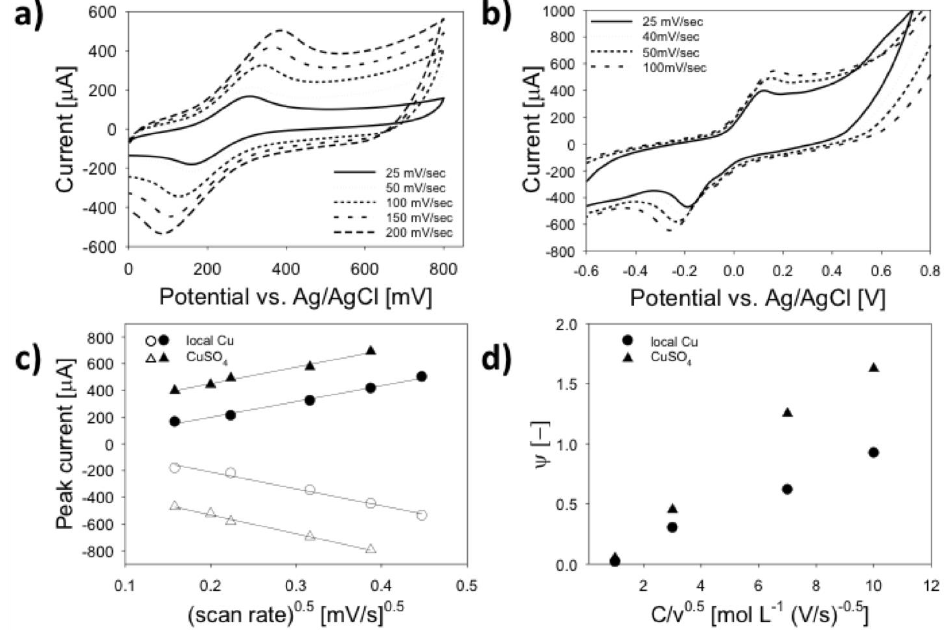
Figure 6. Representative CVs at various scan rates for LSG metallized with two types of copper source material. ( a ) CuSO 4 -plated LSG electrodes display reversible redox peaks; ( b ) LSG electrodes plated with locally sourced copper display quasi-reversible redox peaks below 100 mV/s, but no oxidation peaks are discernable above 100 mV/s (data not shown); ( c ) cottrell plots used to calculate ESA and HET constant were linear ( R 2 > 0.98) between 25 and 200 mV/s for CuSO 4 -plated LSG electrodes; ( d ) HET plots used to calculate k 0 were linear between 25 and 100 mV/s ( R 2 > 0.97) for locally sourced copper-plated LSG electrodes. The geometric surface area of the LSG working electrode was 0.12 cm 2 . Table 1. Summary of material characterization and electrochemical parameters for LSG with two different sources of copper used for metallization.